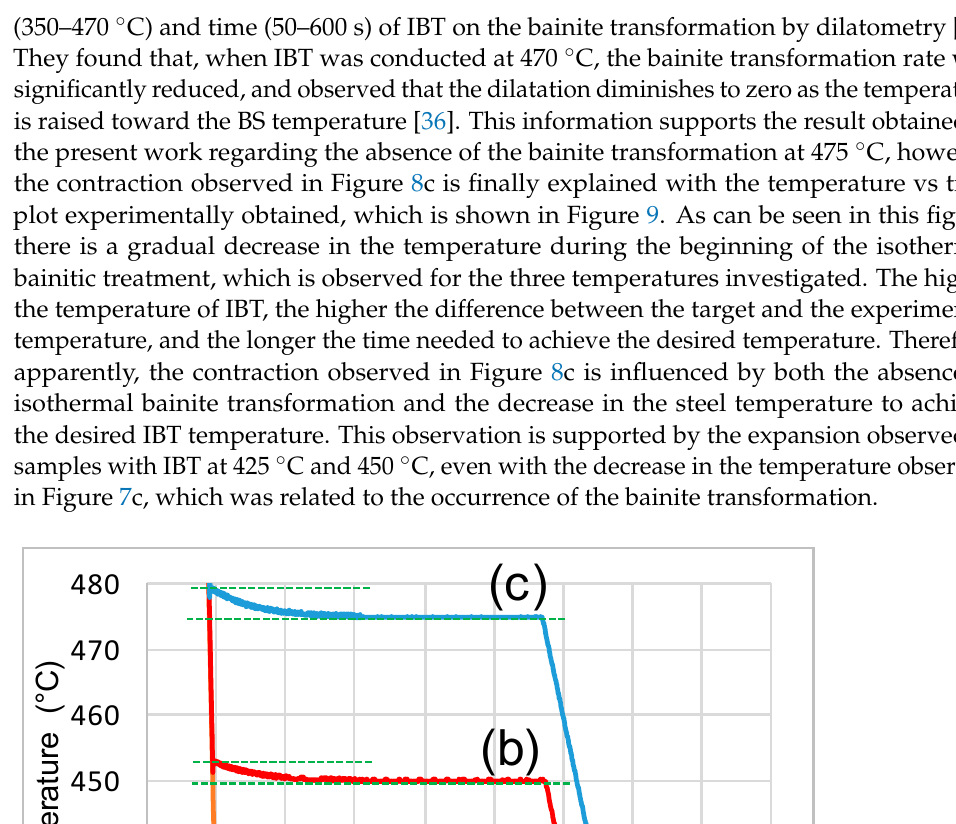
Figure 9. Temperature vs. time plots showing the variation of temperature during isothermal bainitic treatment conducted at: ( a ) 425 °C, ( b ) 450 °C, and ( c ) 475 °C.